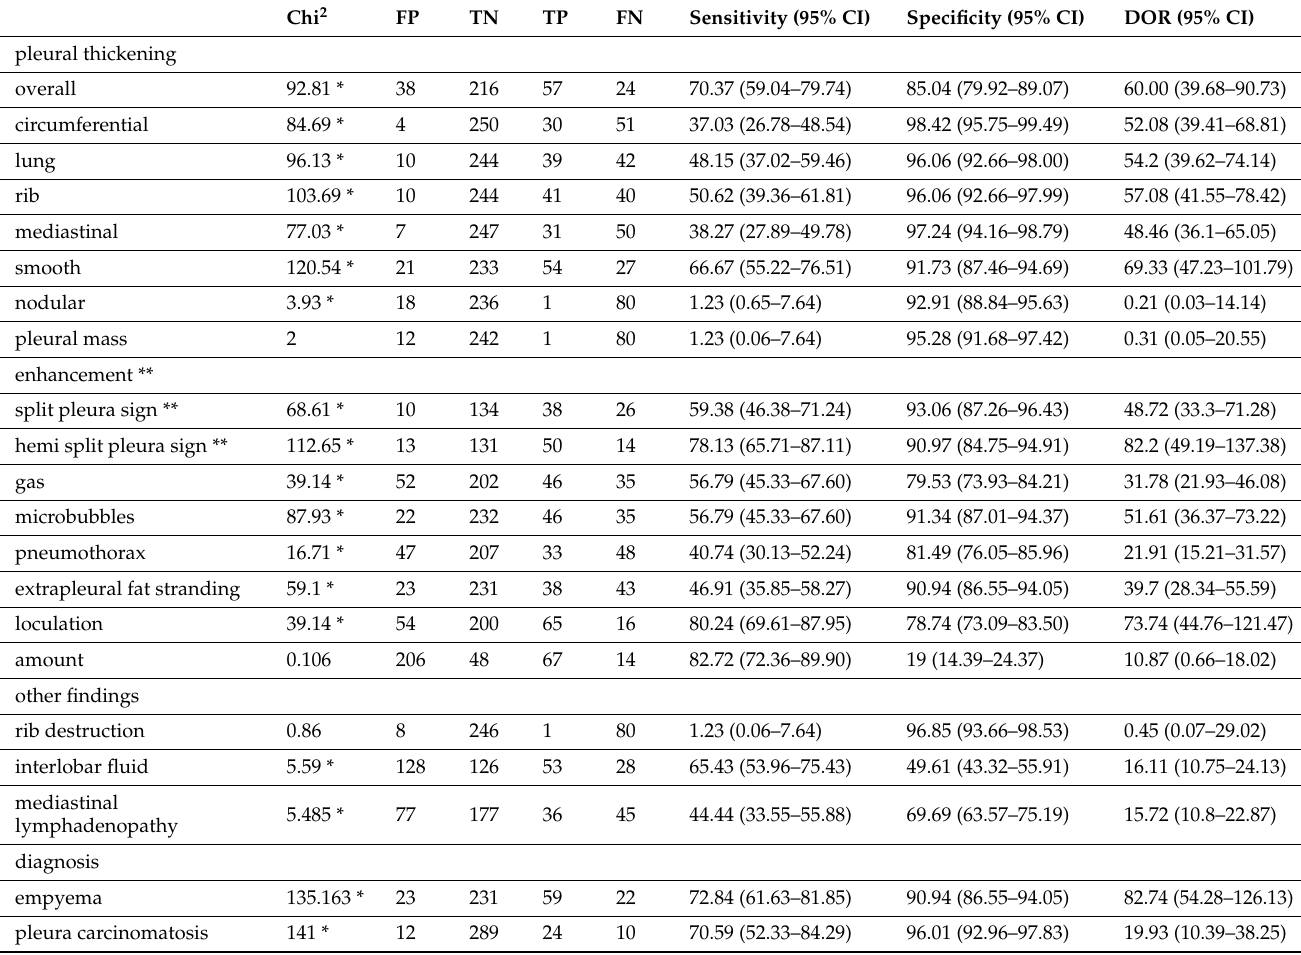
Table 2. Diagnostic accuracy of CT